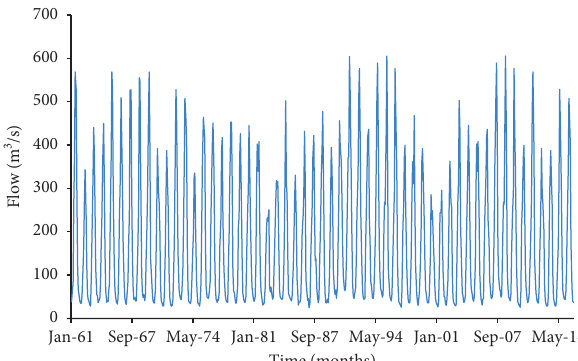
Figure 4: The monthly runoff series of Swat River at